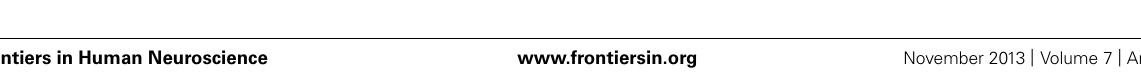
Frontiers in Human